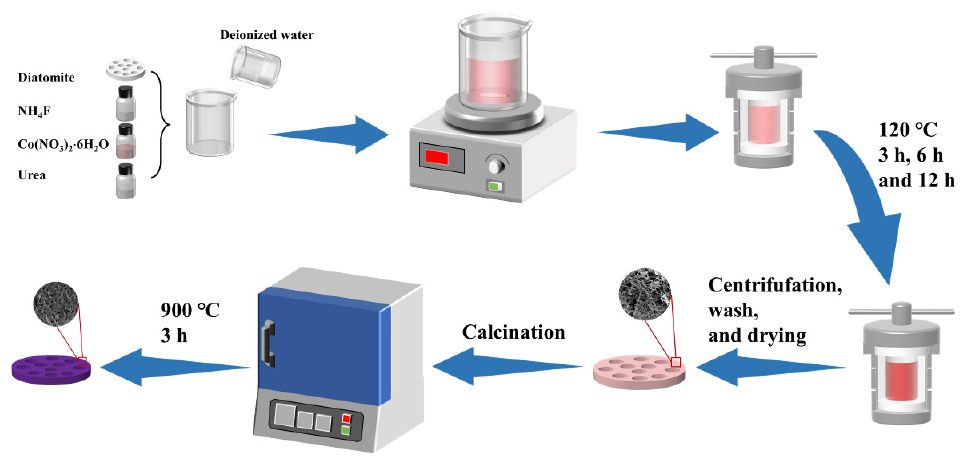
Figure 1. Preparation flow of Co 2 SiO 4 @DE.2.3. Characterization.